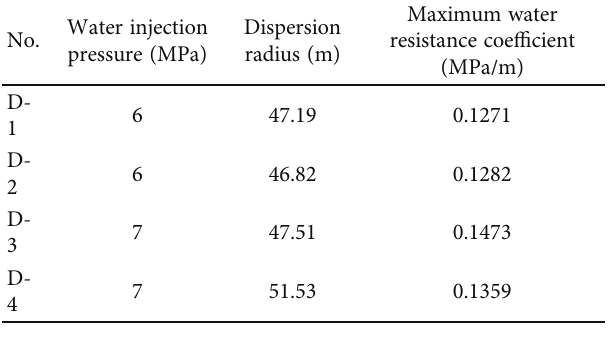
Table 7: Table of water resistance coe ffi cient of 1101 coalface fl oor.